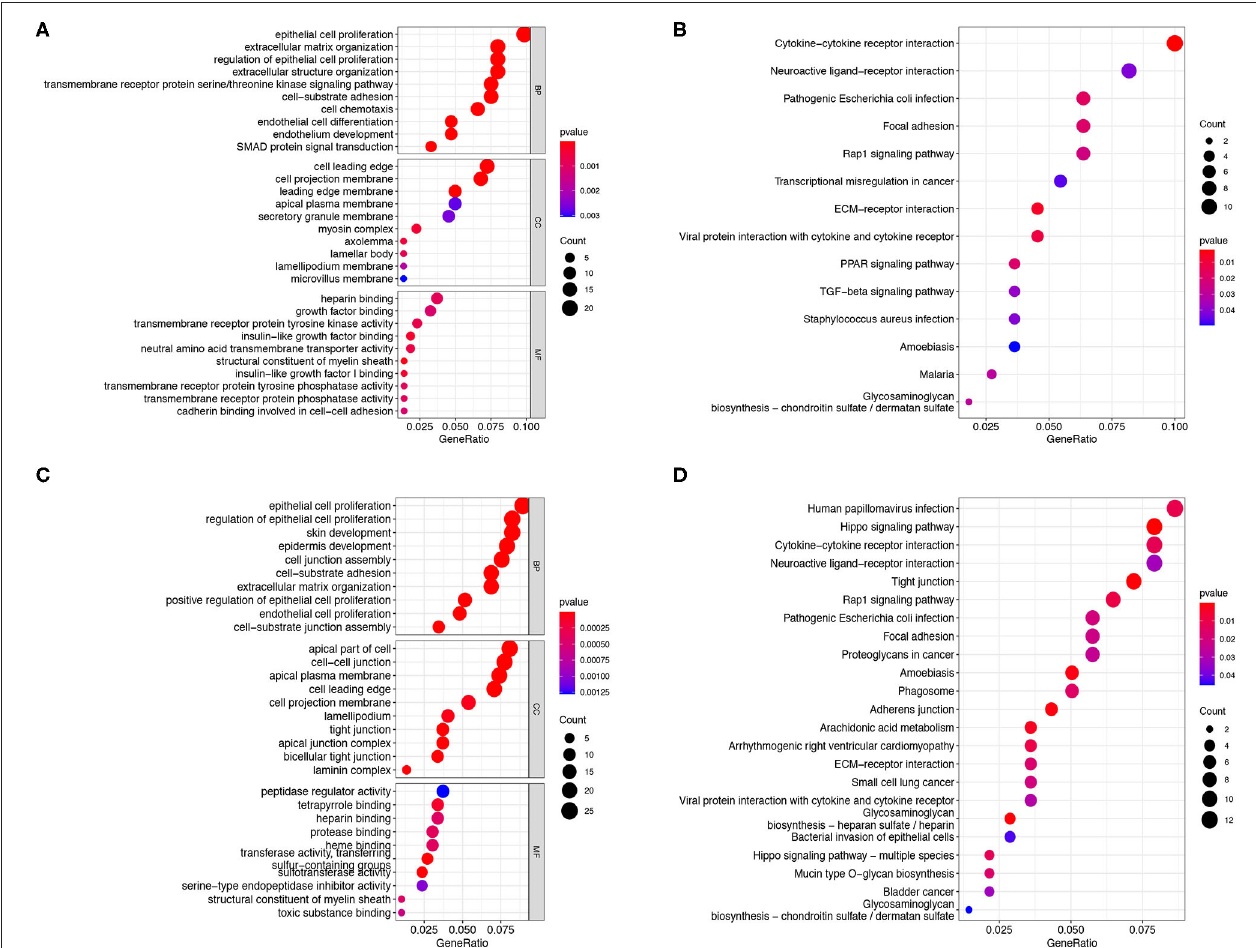
FIGURE 8 | GO and KEGG analysis. The GO enrichment and KEGG pathways of the risk score-related DEGs in the training cohort (A,B) and testing cohort (C,D) . GO, Gene Ontology; KEGG, Kyoto Encyclopedia of Genes and Genome; DEGs, differentially expressed